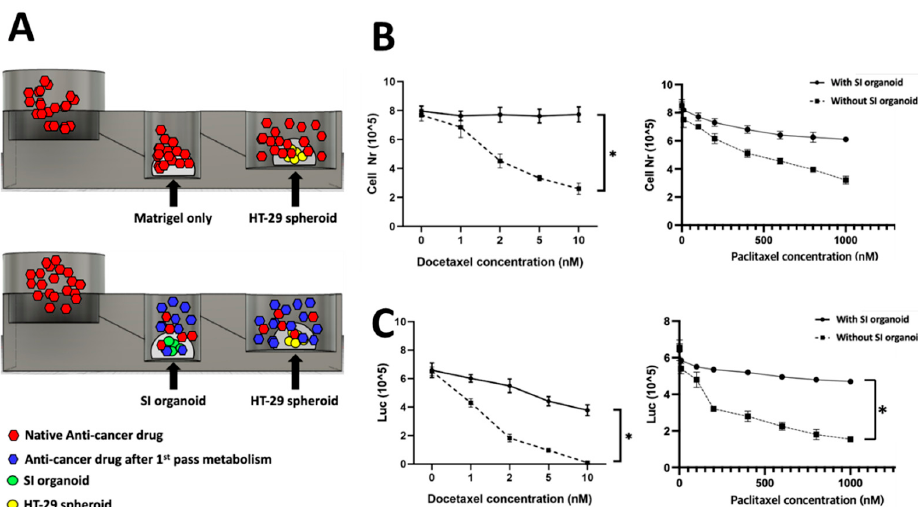
Figure 4. Chip simulation assay. Anti-cancer drug was treated in the first well with or without an SI organoid in the second well. For the control, only Matrigel was placed instead of the SI organoid in the second well. The spheroids’ viability in the third well was measured to validate the working of the FPM chip. When Docetaxel was used to treat the SI organoid, there was no specific change of the spheroids’ viability in the third well, but the Docetaxel without the organoid significantly decreased the viability at 72 h. Scheme of the simulation assay ( A ), total cell number and metabolic activity assay using CellTiter Glo ® 3D after 72 h flow in Docetaxel ( B ) and Paclitaxel ( C ). The differences were considered significant at p < 0.05 (*).